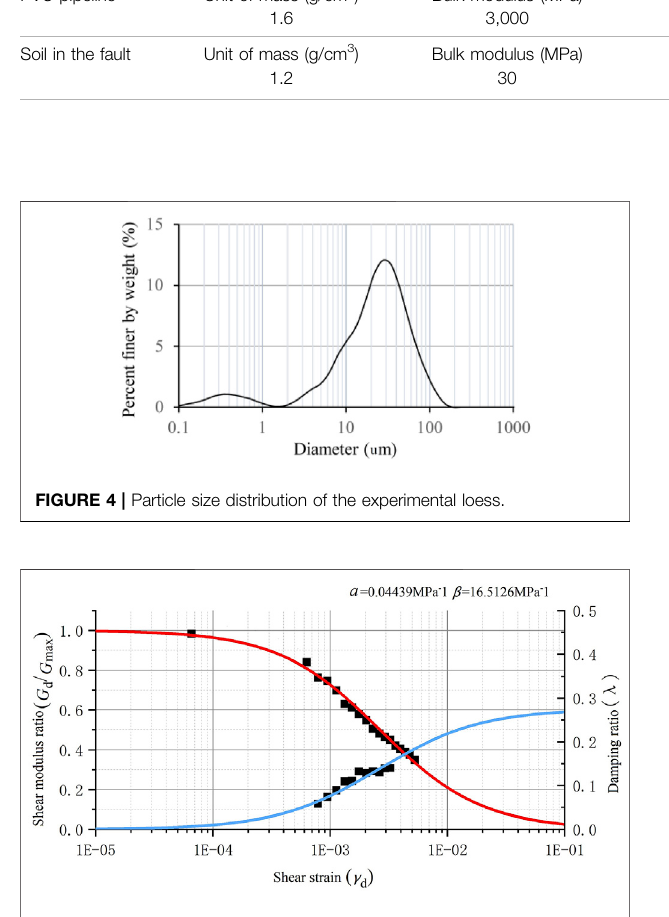
FIGURE 5 | Curves of the dynamic modulus of elasticity and damping